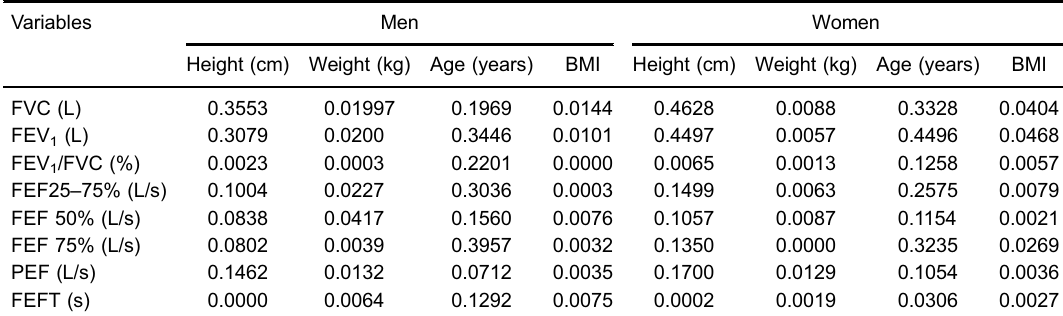
Table 2. Correlations (r 2 ) of spirometric indices with anthropometric data.